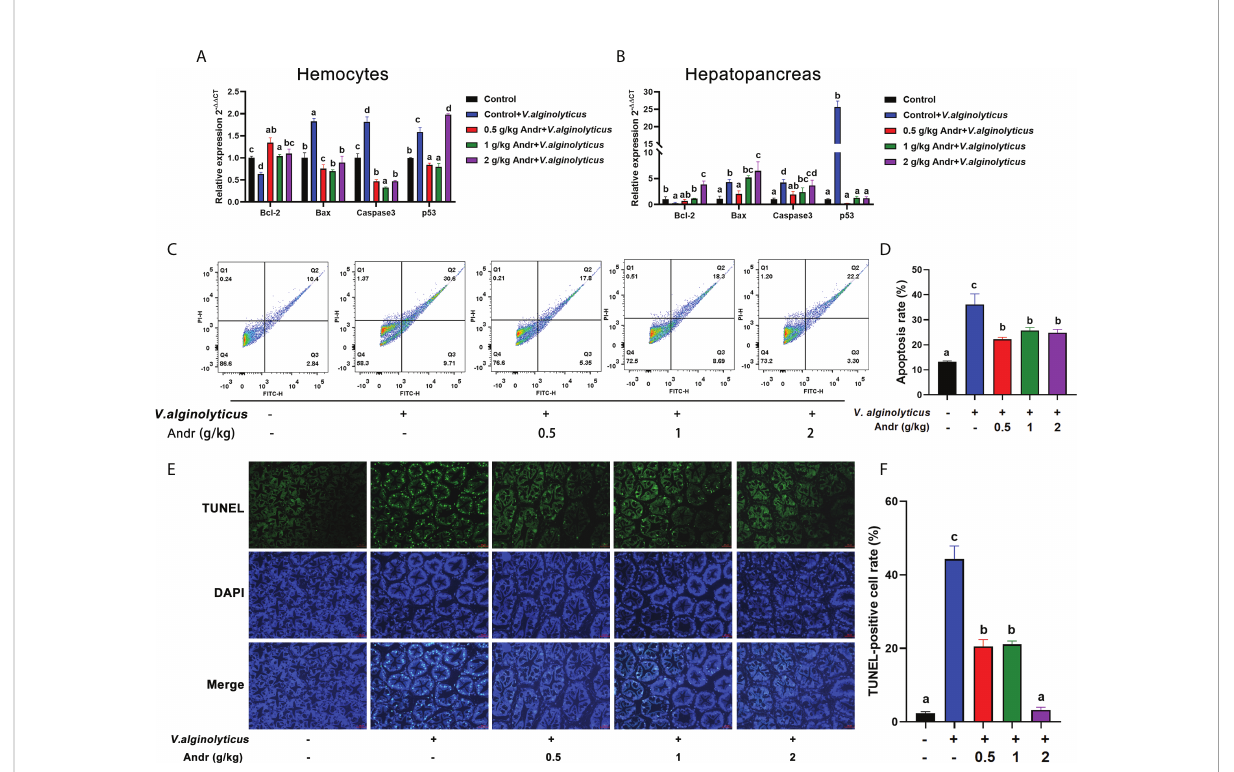
FIGURE 6 Andr inhibits cell apoptosis induced by V. alginolyticus infection on L. vannamei . (A, B) The expression of apoptosis-related gene in hemocytes and hepatopancreas of L. vannamei under V. alginolyticus infection 6 h. (C, D) Detection of apoptosis in hemocytes of L. vannamei by fl ow cytometry after V. alginolyticus infection 6 h. (E, F) Detection of apoptosis in hepatopancreas of L. vannamei by TUNEL stain after V. alginolyticus infection 6 h. Values are means ± SD. a,b,c,d Value bars not sharing the same superscript letter are signi fi cantly different as evaluated by Duncan ‘ s test ( p <